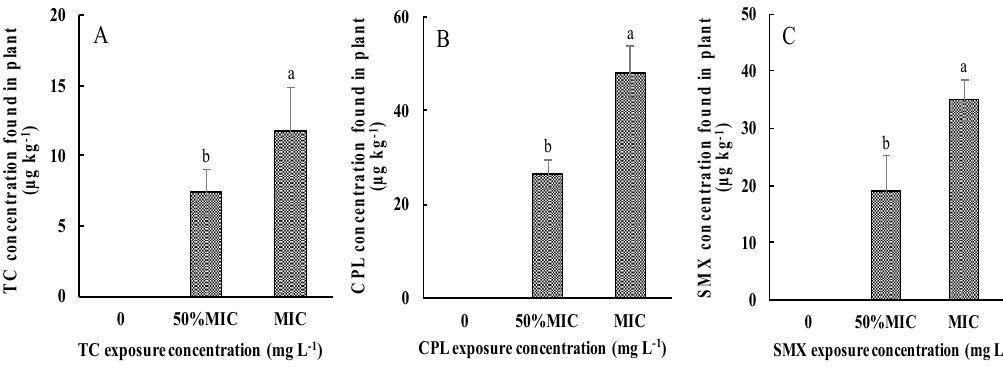
Figure 2. Accumulation of antibiotics in hydroponic pakchoi under different dosages of antibiotic exposure. ( A ) TC exposure treatment; ( B ) CPL exposure treatment; ( C ) SMX exposure treatment. Values are mean ± SD ( n = 3). Different letters on the top of the error bars indicate statistical difference among the treatments ( p < 0.05).